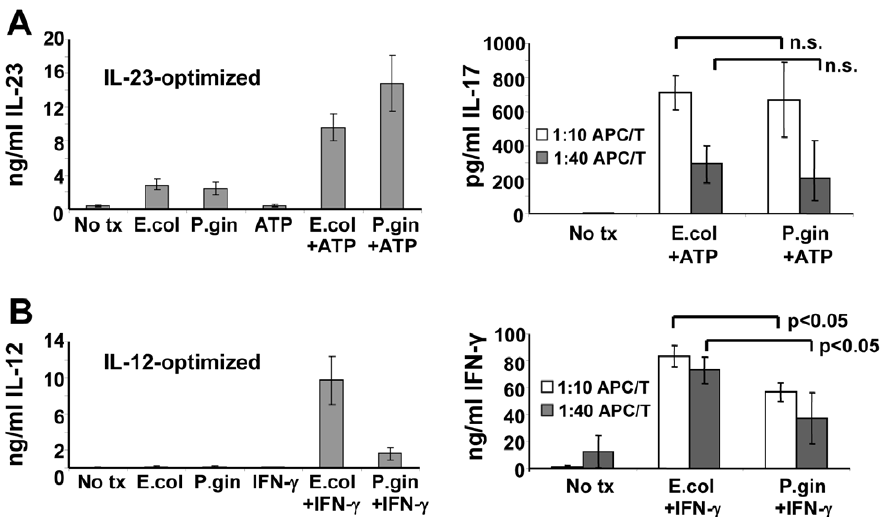
Figure 7. Differential regulation of IL-12 and IL-23 by structurally-divergent lipopolysaccharides leads to distinct Th-deviating profiles. (A) Monocytes cultured in SFM supplemented with GM-CSF only (IL-23 optimized). Cells were pre-treated with ATP for 4 h prior to application of E. coli K12 or P. gingivalis LPS. Culture supernatants were harvested 24h later and analyzed for IL-23 by ELISA (left panel). Monocytes from replicate cultures were harvested 6 h after LPS activation and co-cultured with CD4 pos Th at indicated stimulator:responder ratios. Co-culture supernatants were harvested 5 days later and analyzed for IL-17 production (right panel). (B) MoDC cultured overnight in SFM with GM-CSF plus IL-4 (IL-12 optimized). Cells were then pre-treated with IFN- c (IL-12 optimized) for 4–6 h prior to application of 500ng/ml LPS from either E. coli K12 strain or P. gingivalis . Culture supernatants were harvested 24 h later and analyzed for IL-12 p70 by ELISA (left panel). MoDC harvested from replicate cultures were were co-cultured with allogeneic CD4 pos T cells at indicated stimulator:responder ratios with supernatants harvested 5 days later and assayed for IFN- c production by ELISA (right panel). Data from 4 separate allogeneic APC’’T cell pairings + / 2 SEM.